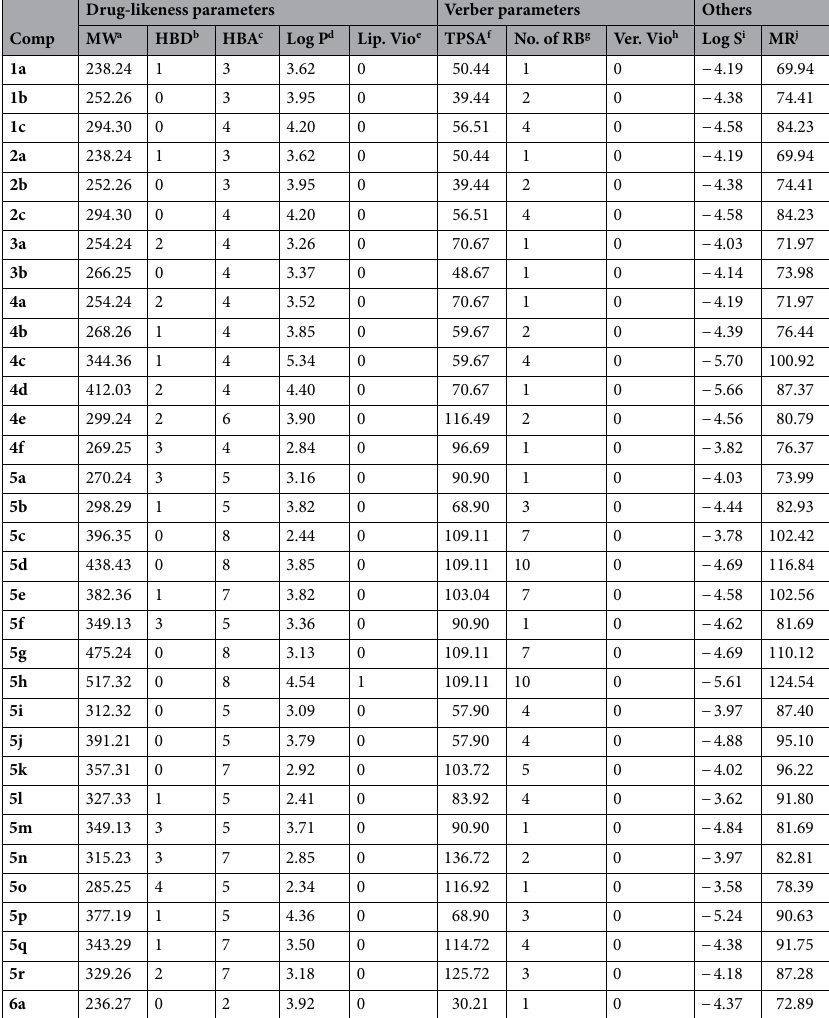
Table 2. Predicted physicochemical properties and drug-likeness of flavone analogs. a MW = Molecular weight: ≤ 500; b HBD = Hydrogen bond donors: ≤ 5; c HBA = Hydrogen bond acceptors: ≤ 10; d Log P = log of octanol to water partition coefficient: ≤ 5; e Lip. Vio. = Lipinski Violations; f TPSA = Total polar surface area [A°] 2 : ≤ 140;